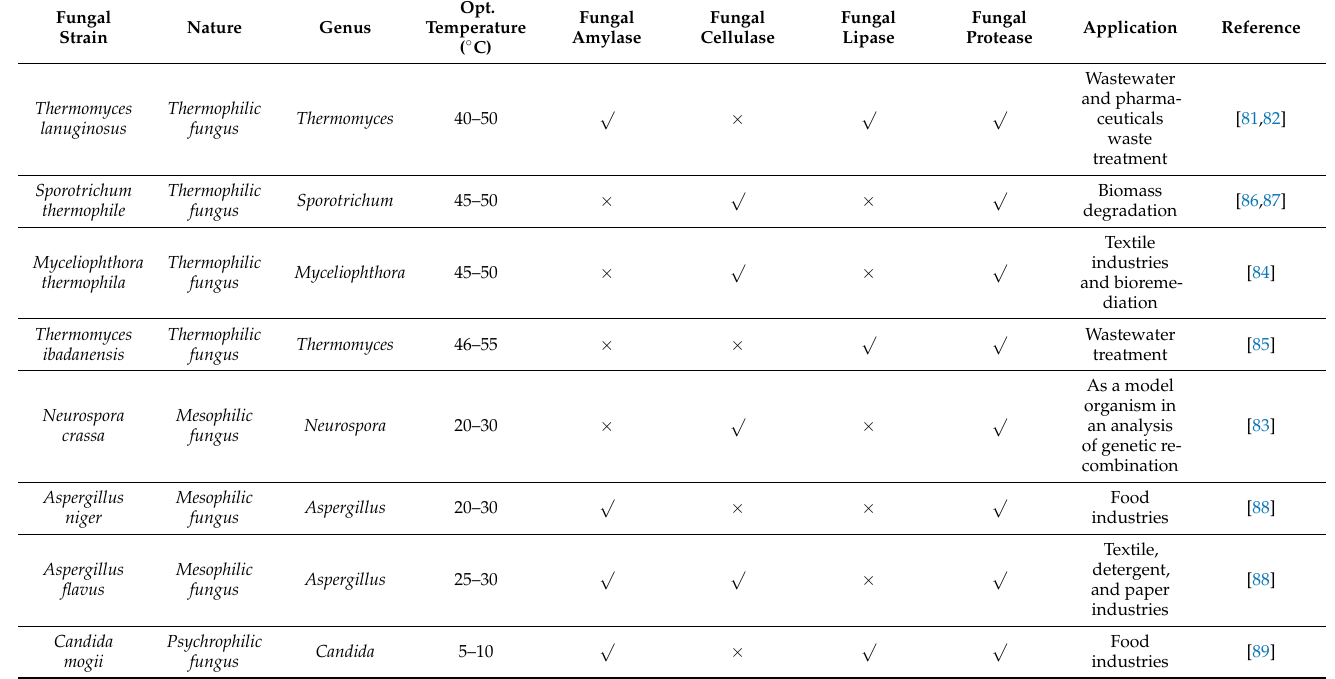
Table 2. The coproduction of fungal enzymes from different strains of fungus based on